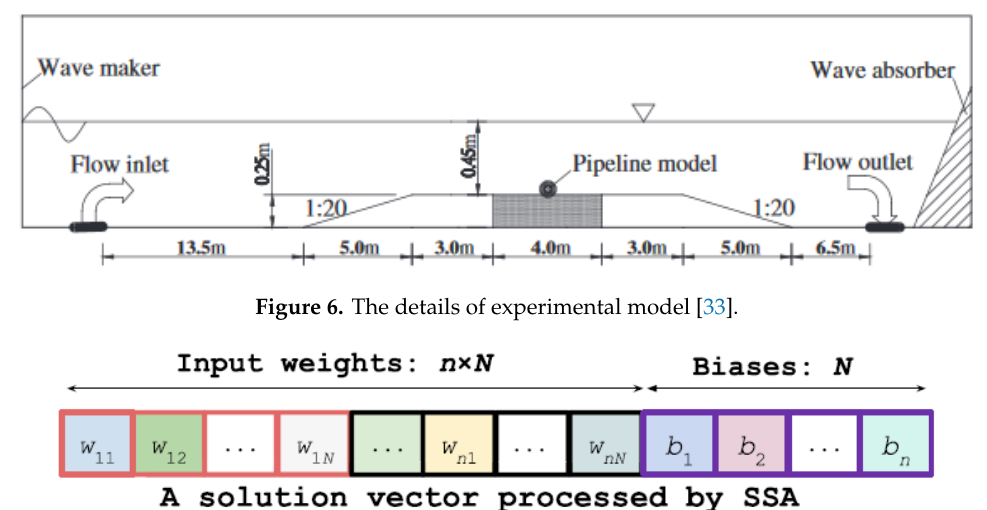
Figure 7. Structure of a decision variable in the Salp Swarm Algorithm (SSA) including bias and weight.